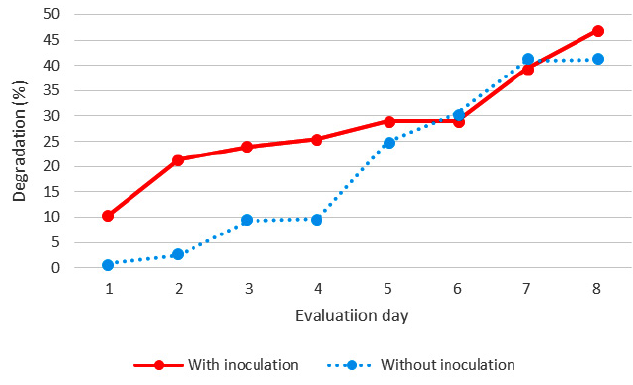
Fig. 2. Malathion degradation in presence and absence of bacterial consortium